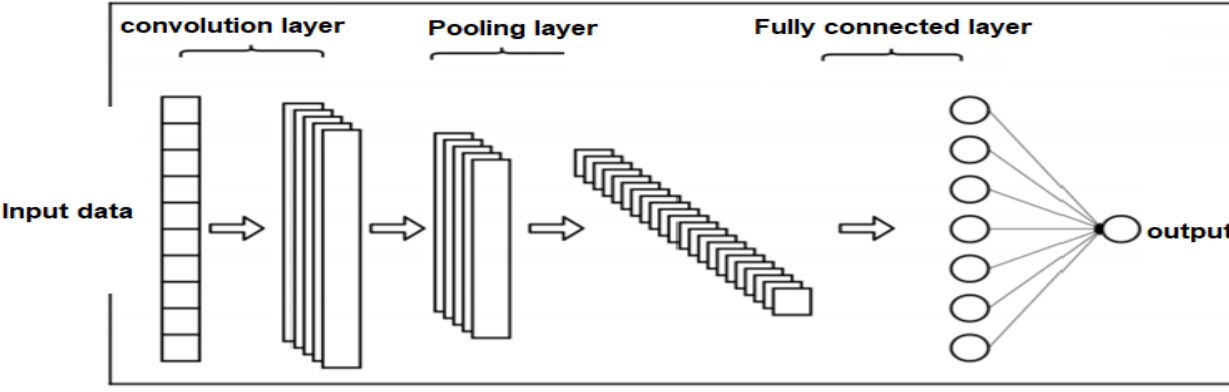
Figure 3. Structure of a